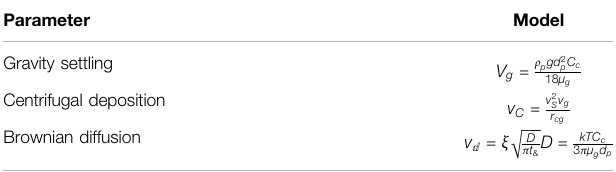
TABLE 3 | Aerosol deposition velocity in the rise zone. Parameter